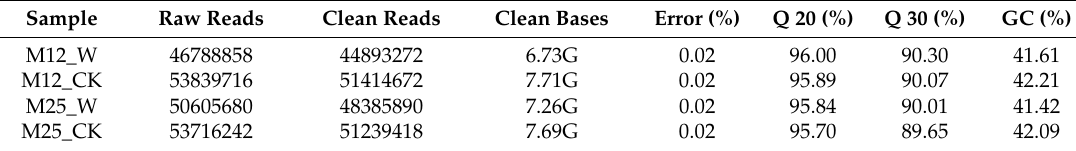
Table 1. Summary of sequence assembly after illumina sequencing.